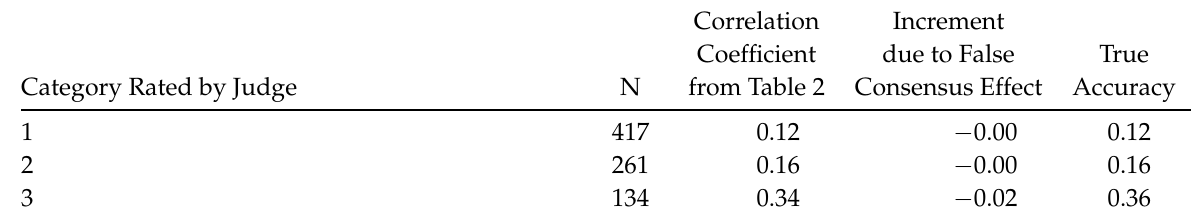
Table 5: Accuracy of prediction by degree of social closeness perceived by